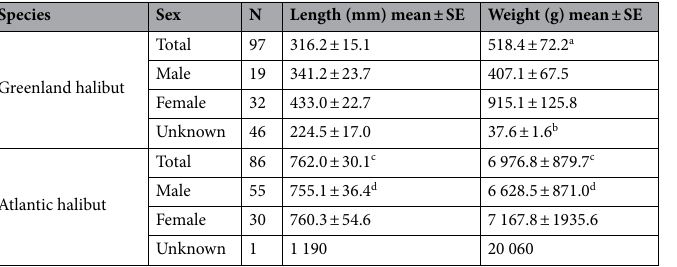
Table 1. Summary of the fish samples used for cmDNA analysis. Number of samples for which the data were available: a n = 73, b n = 22, c n = 85 and d n = 54.